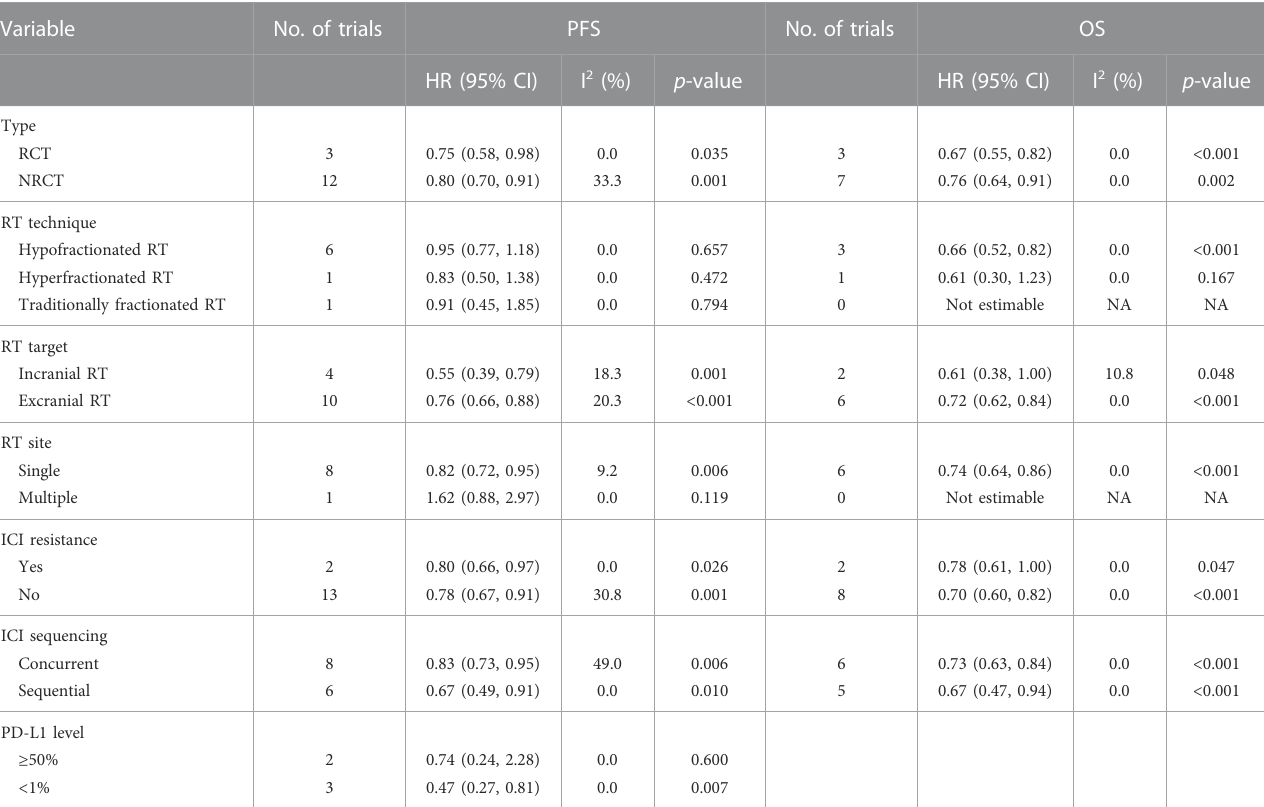
TABLE 2 Subgroup analysis of PFS and OS of RT combined with ICIs versus ICIs alone in mNSCLC. Variable